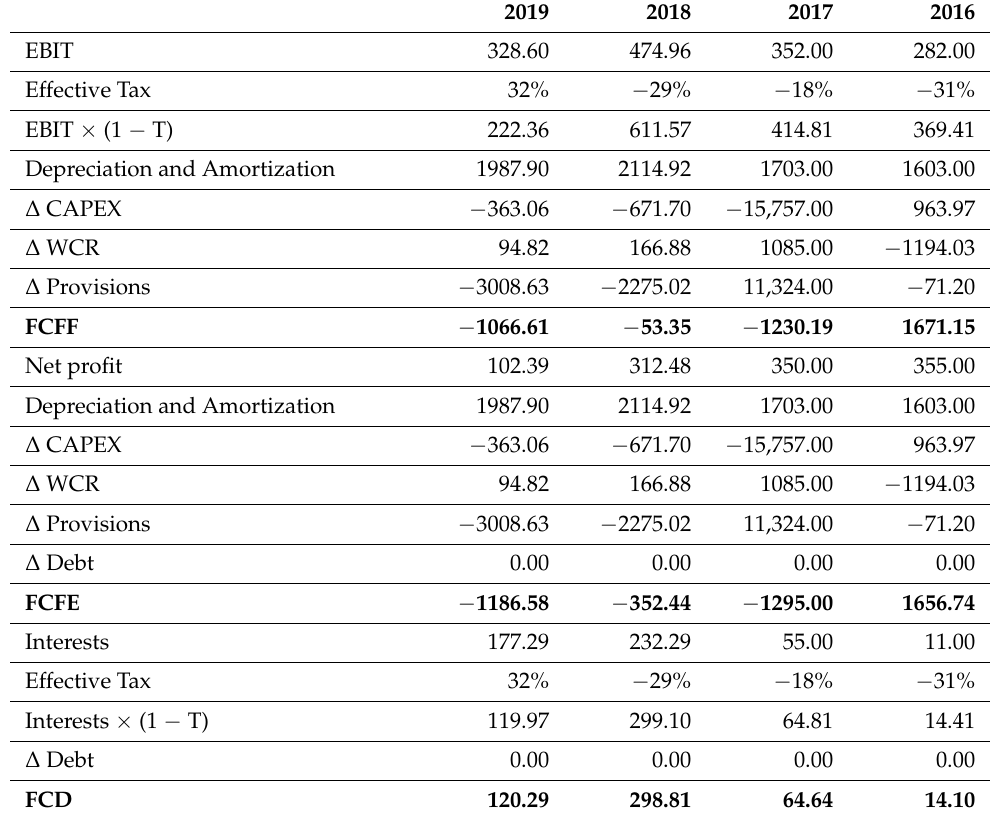
Table 10. Formation of FCFF, FCFE and FCD flows and the components affecting them in Geotermia Pyrzyce Sp. z o.o. (PLN